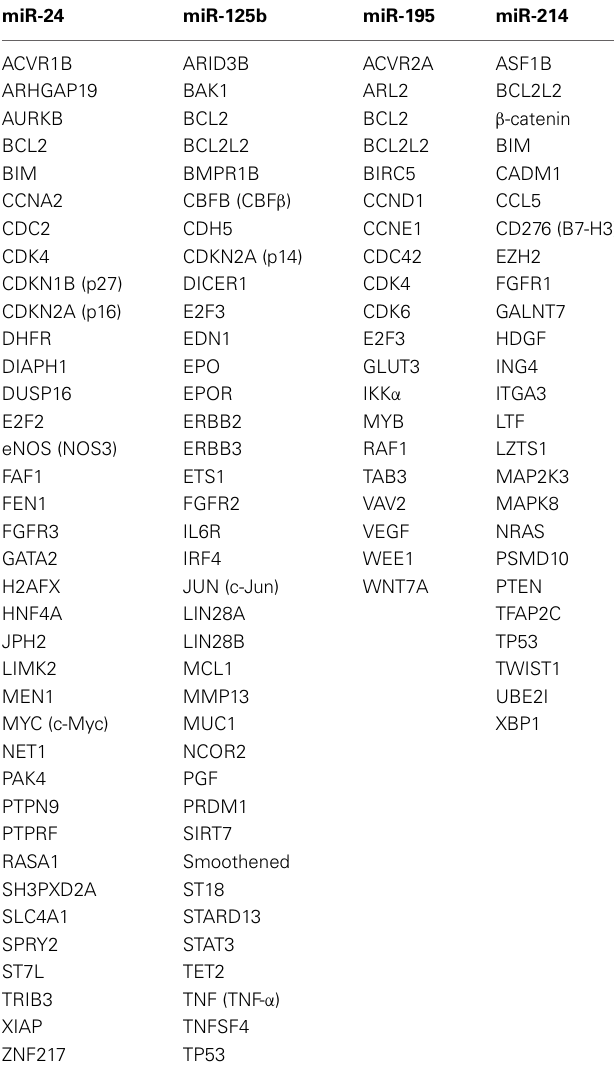
Table 1 | Validated targets of miR-24, miR-125b, miR-195, and